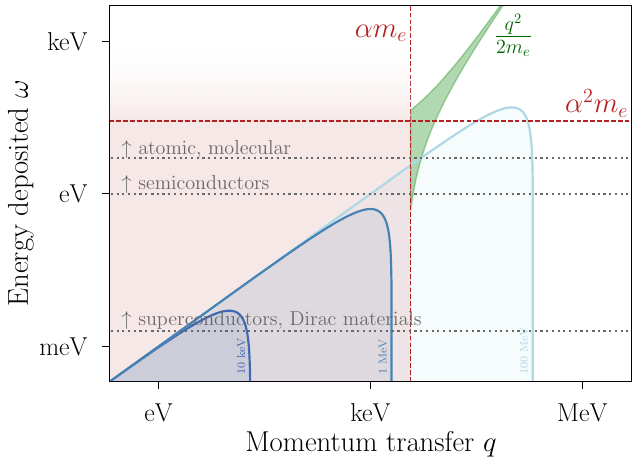
Figure 3: For DM-electron interactions, the response at high q is peaked about the ) . The dashed lines at q ∼ 1 / a = α m free-electron dispersion ω = q 2 / ( 2 m and e e 0 ω ∼ α 2 m indicate typical scales for the wavefunction spread and energies of bound e electrons. Many-body effects are expected to be particularly important at lower q , ω , indicated by the shaded region. Depending on the target material and detection method, the relevant response function will be cut off at low ω ; we show typical gaps for ionization in atomic systems, scintillation in molecules, electron-hole excitations in semiconductors, and gapped excitations in superconductors and Dirac materials. Kinematically allowed regions for DM scattering are shown for m χ = 10 keV, 1 MeV, and 100 MeV at v = 10 − 3 , as in Fig.